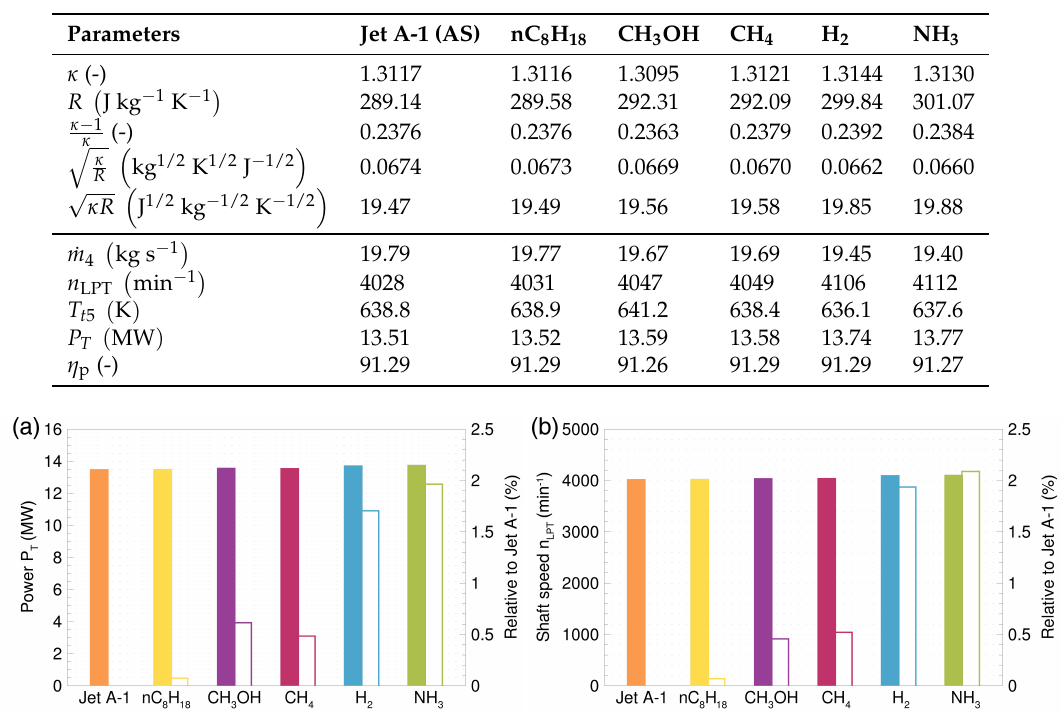
Figure 9. Comparison of turbine power output ( a ) and shaft speed of the low pressure turbine ( b ) at constant operating conditions. Absolute and relative to Jet A-1